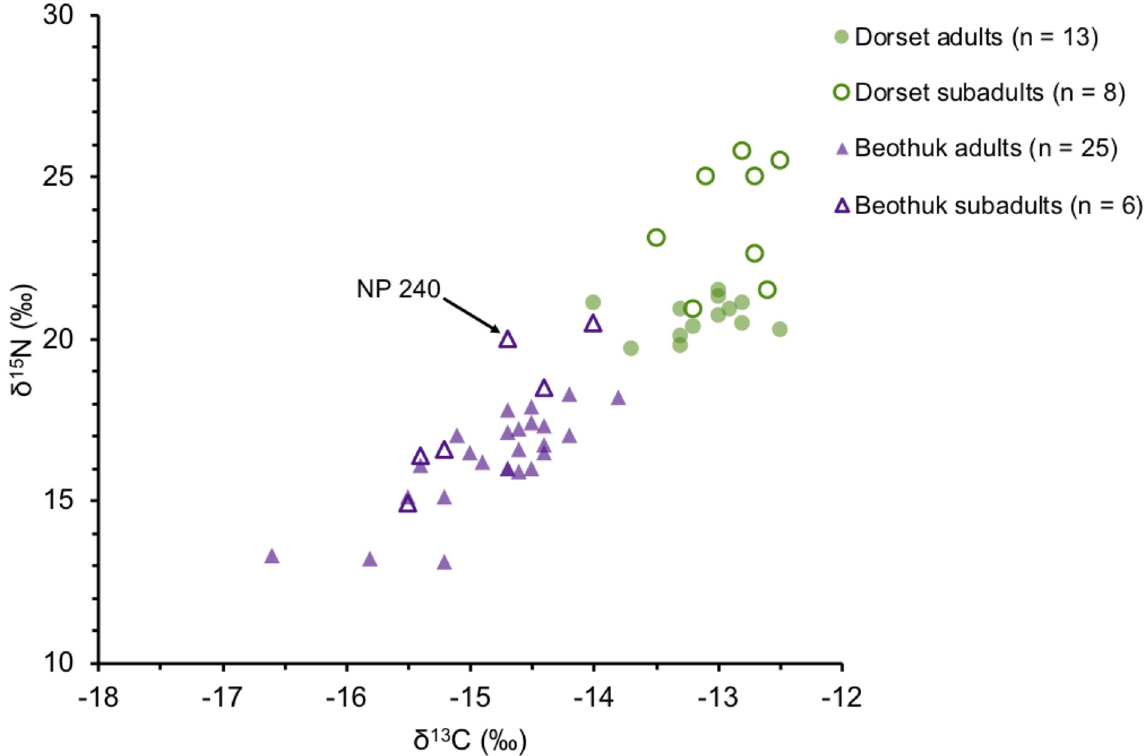
Fig 5. A comparison of the stable isotope values of Dorset and Beothuk adults and subadults. The naturally mummified subadult, NP 240, is indicated by an arrow. Includes published data from Duggan et al. 2017, Raghavan et al. 2014, and Kuch et al.